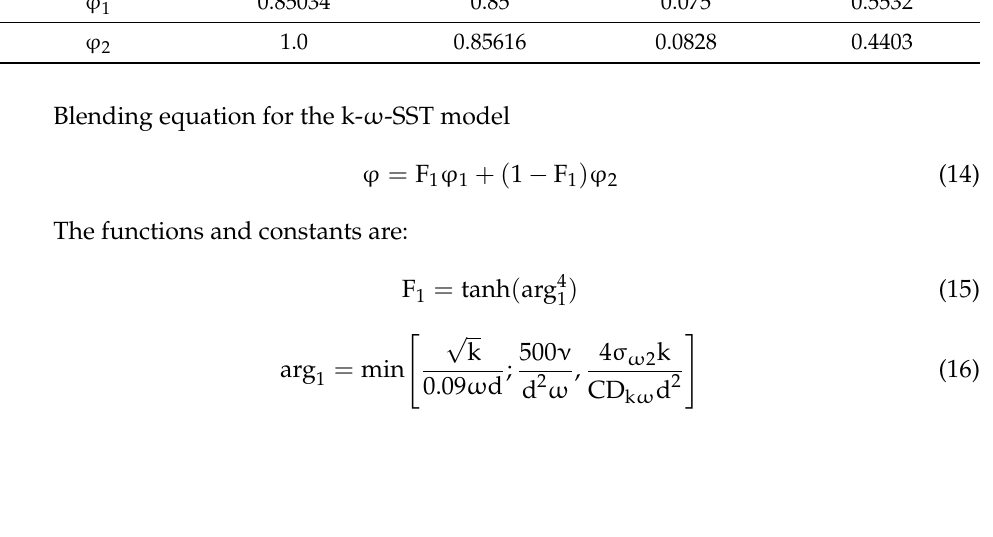
Table 1. Various constants used in the k- ω -Shear Stress Transport (k- ω SST) turbulence model. Φ σ